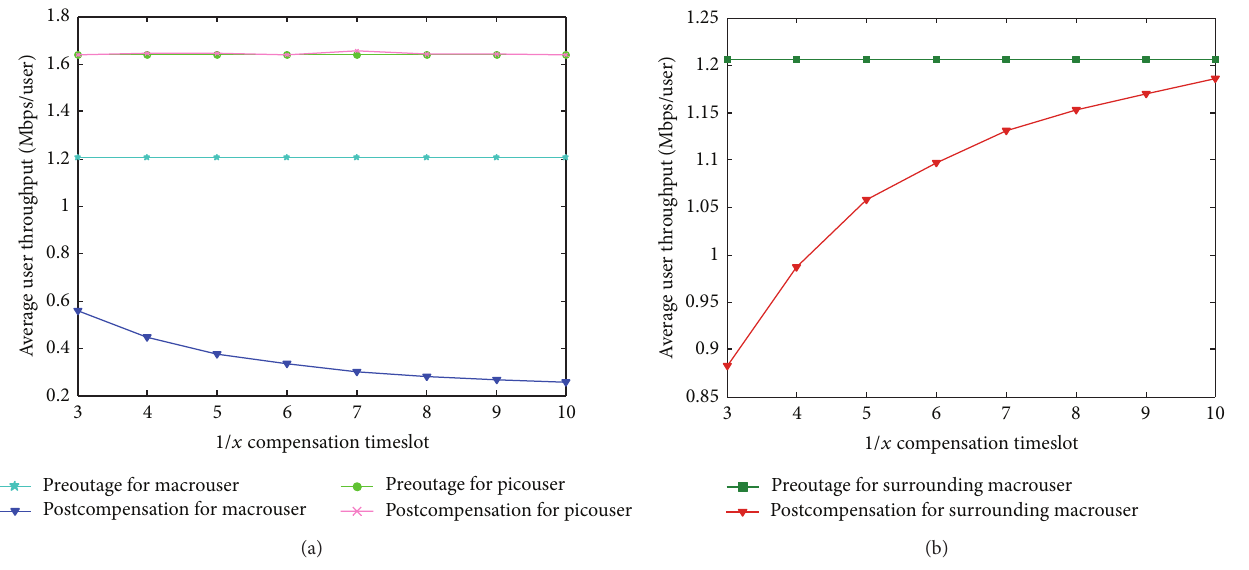
Figure 6: Average user throughput with respect to various proportions of compensation timeslot: (a) users in the outage area and (b) users in the surrounding macroarea.